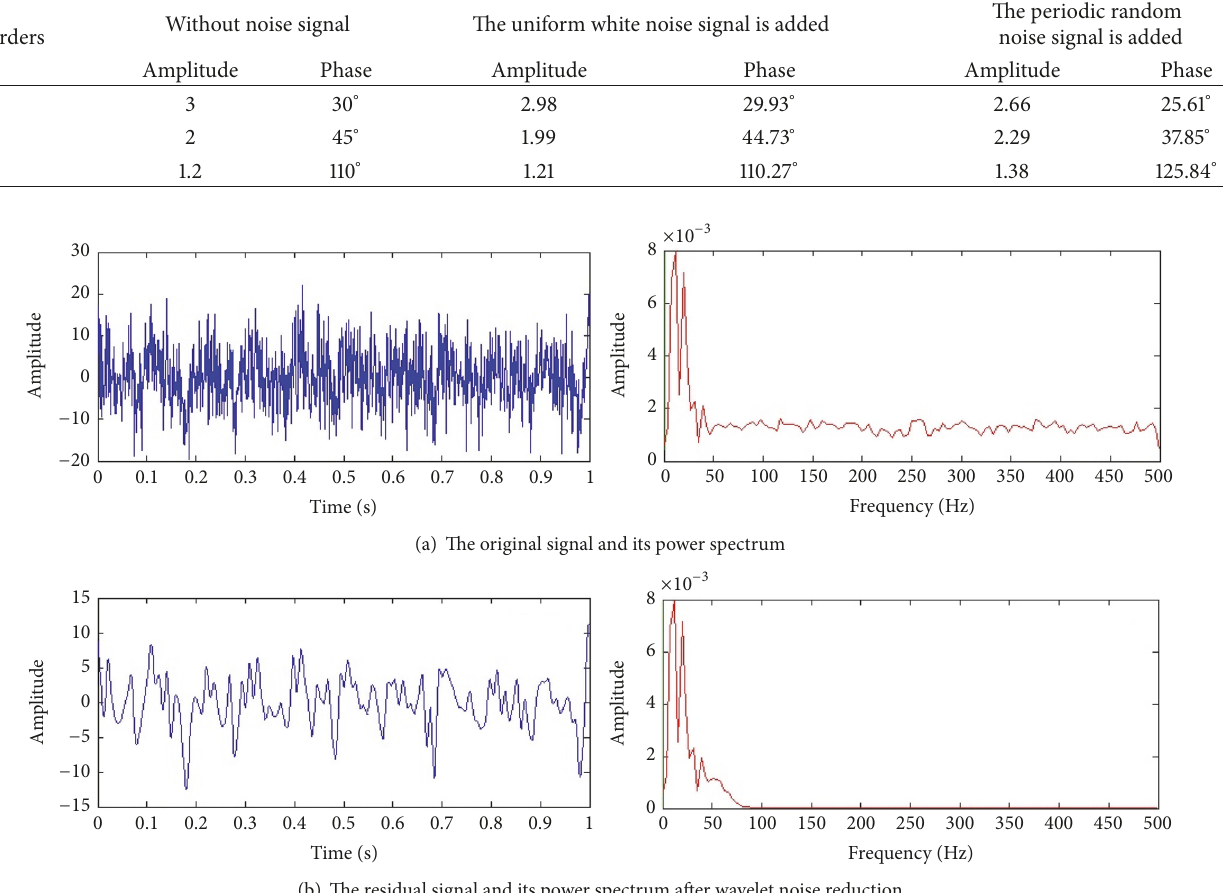
The periodic random noise signal is added